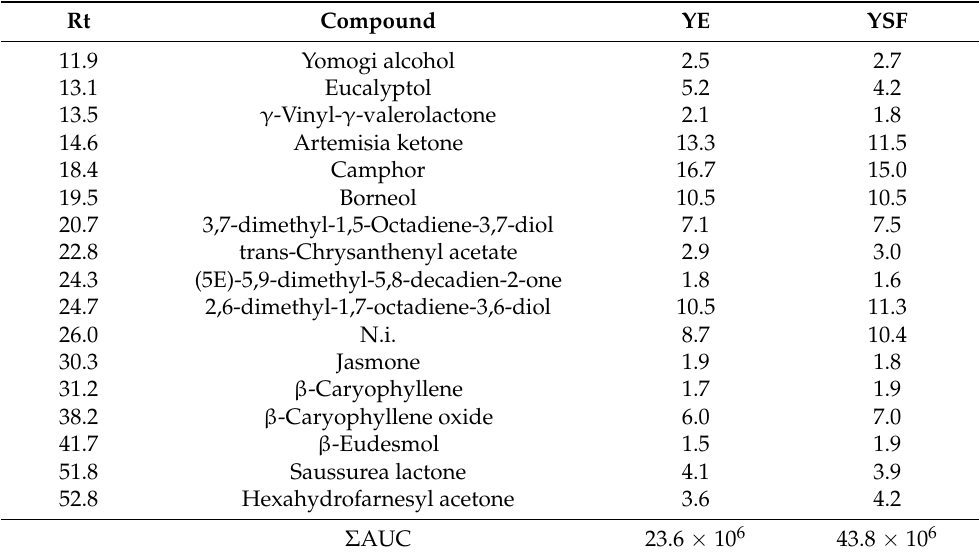
Table 2. Volatile compounds identified by GC-MS in YE and YSF represented as peak area contribu- tions (normalized percentage of